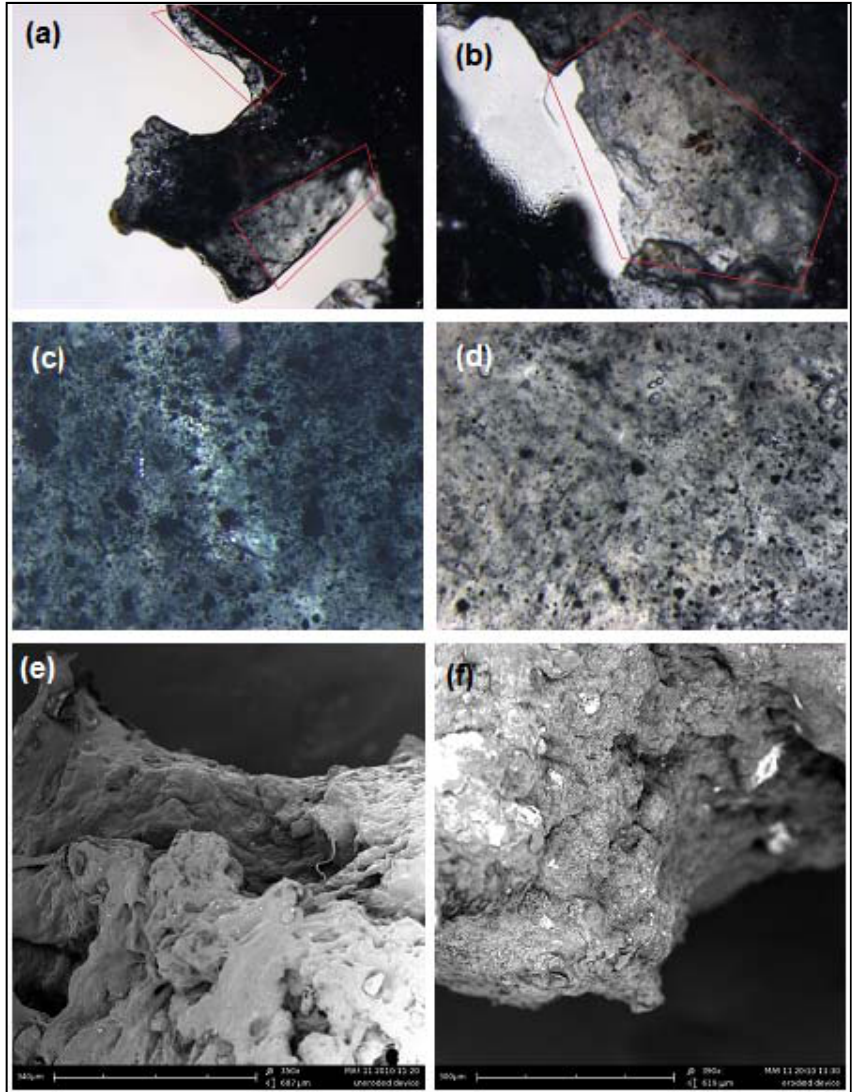
Figure 1. Light micrographs of the ECH showing: ( a ) and ( b ) eroded sites of the ECH (highlighted in red) (×32); ( c ) 3 % w / micrographs of the ECH showing: ( e ) the non-eroded region (×350) and ( f ) the eroded region